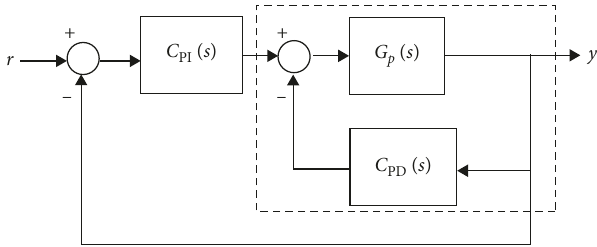
Figure 1: The PI-PD control system for generalized fractional